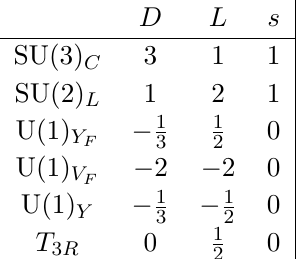
, U(1) V , U(1) Y , and T 3 . R F F (SU(2) ) as R ( R 0 ) n d